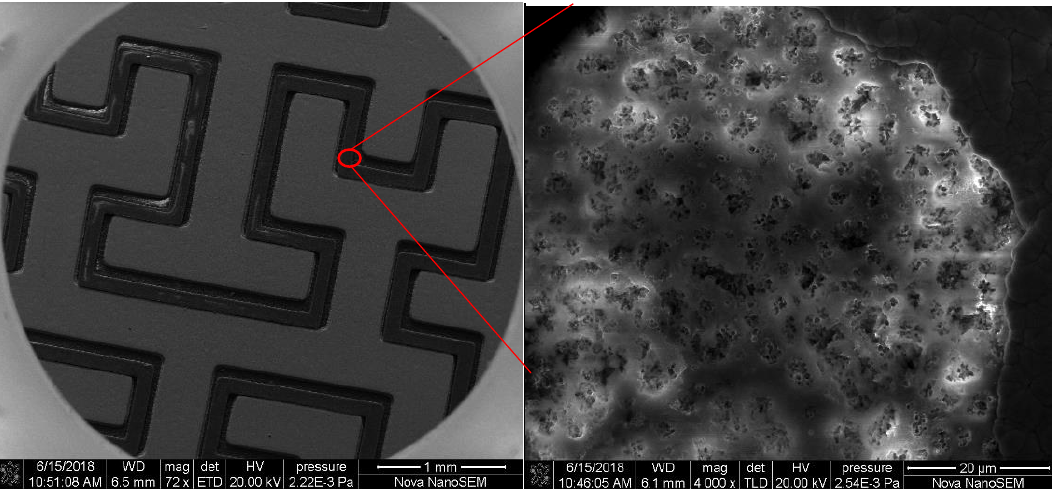
Figure 9. SEM images of multi-walled carbon nanotube films at different magnifications (scale bars, left : 1 mm; right : 20 μ m).